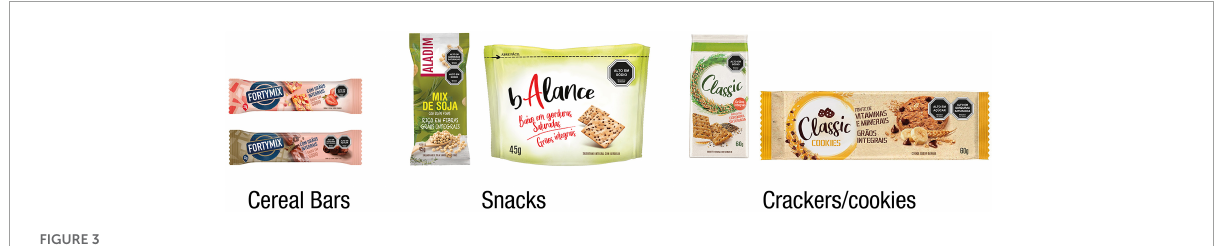
FIGURE3 Food categories considered in the study with an example of the octagon